Question: Compose a caption that would accompany this figure in a paper.
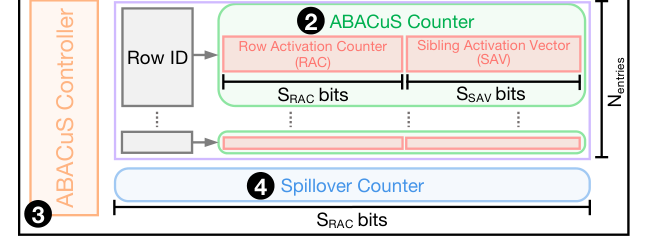
Answer: Key components of ABACuS The row activation counter (RAC) in an ABACuS counter (❷) stores the maximum activation count across all sibling rows’ activation counts. The sibling activation vector (SAV) stores the sibling activation bits used by ABACuS to increment the RAC only when necessary (see §4). The ABACuS controller updates RAC and SAV to ensure the maximum activation count among all sibling rows is tracked in the RAC. 4.2. Operation of ABACuS We describe ABACuS’s operation in five key steps: i) initial- ization, ii) ABACuS counter table search, iii) ABACuS counter update, iv) ABACuS counter replacement, and v) periodic reset. (1) Initialization and Reset. Initially (at system power on) and after periodic ABACuS counter table reset (Step 5), no DRAM row is activated for the last tREF W . Thus, row activa- tion counters (RACs) and sibling activation vectors (SAVs) in all ABACuS counters and the spillover counter all store 0. (2) ABACuS Counter Table Search. The memory cont